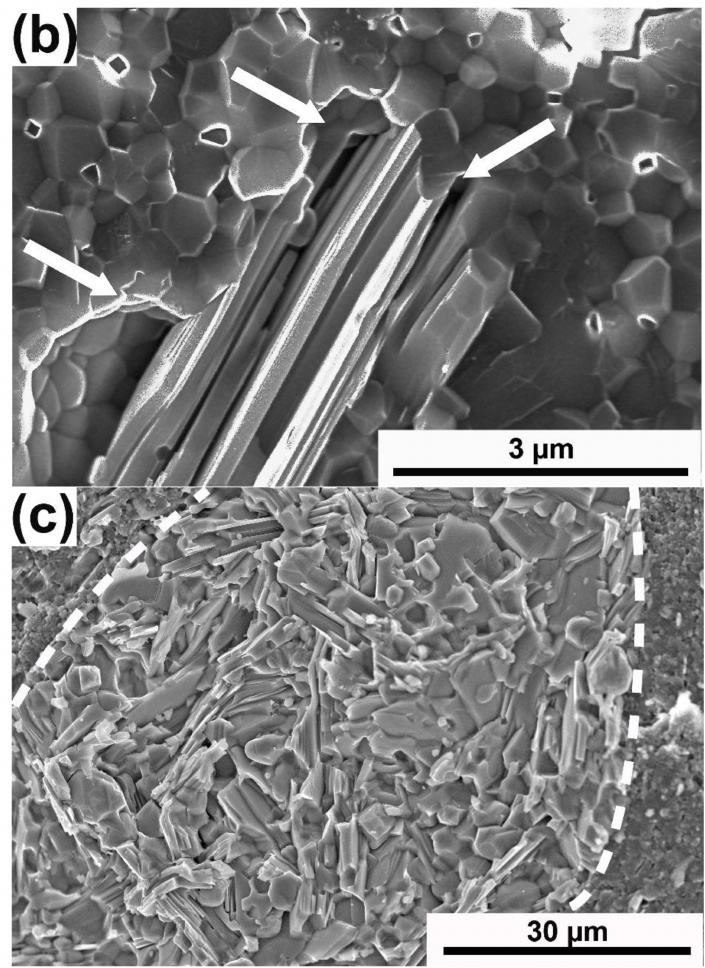
Figure 4. The microstructure of ( a ) Al 2 O 3 —5 wt% of Ti 3 AlC 2 from planetary mill, ( b ) Al 2 O 3 —5 wt% of Ti 3 AlC 2 from Atrittor mill ( c ) Al 2 O 3 —5 wt% of Ti 3 AlC 2 from horizontal mill (the arrows mark the porosity on the